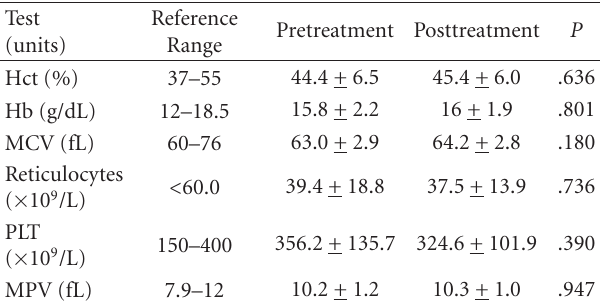
Table 2: Serum iron profile and CRP modification pre- and